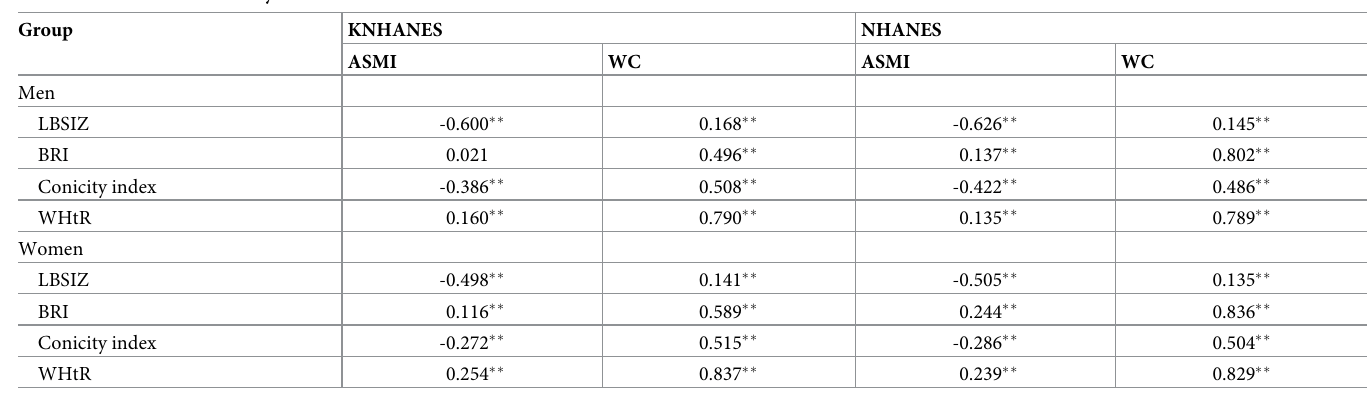
Table 3. Correlation of obesity indices with ASMI and waist